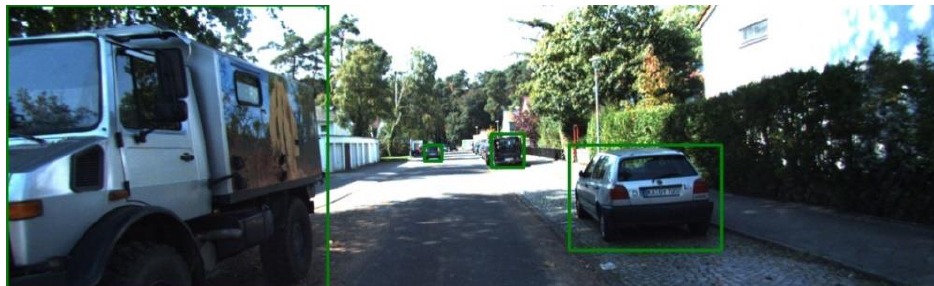
Figure 1. In KITTI training dataset the green boxes indicate the annotated ground truth bounding boxes. The labeling errors of the truck on the left and the car on the right cannot be ignored, and the box of the black car in front is too small.